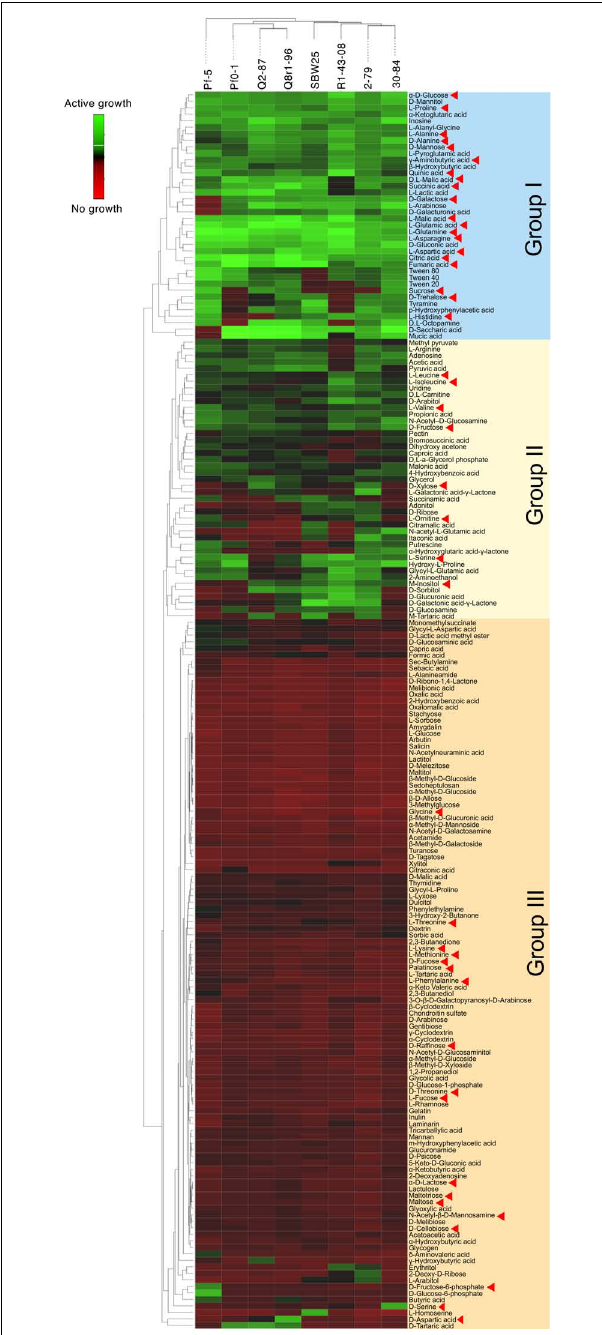
FIGURE 3 | Biolog Phenotype MicroArray profiling the eight rhizosphere Pseudomonas strains used in the study. The hierarchical clustering analysis was carried out using the average linkage method with Euclidean distances. Carbon sources identified by red arrowheads were also detected in the sterile root exudates of B. distachyon